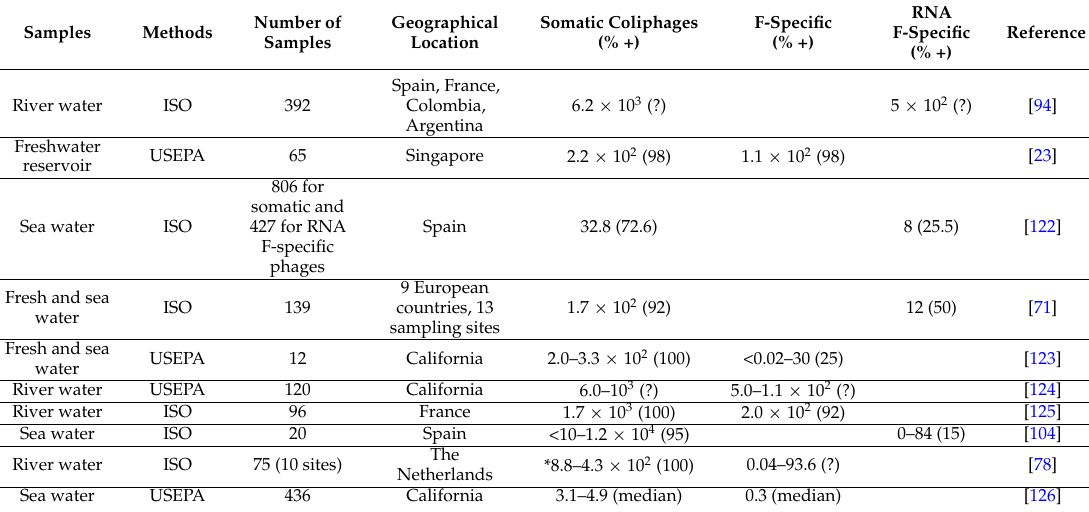
Table 1. Number of bacteriophages (PFU / 100mL) in surface water. * Average per site.